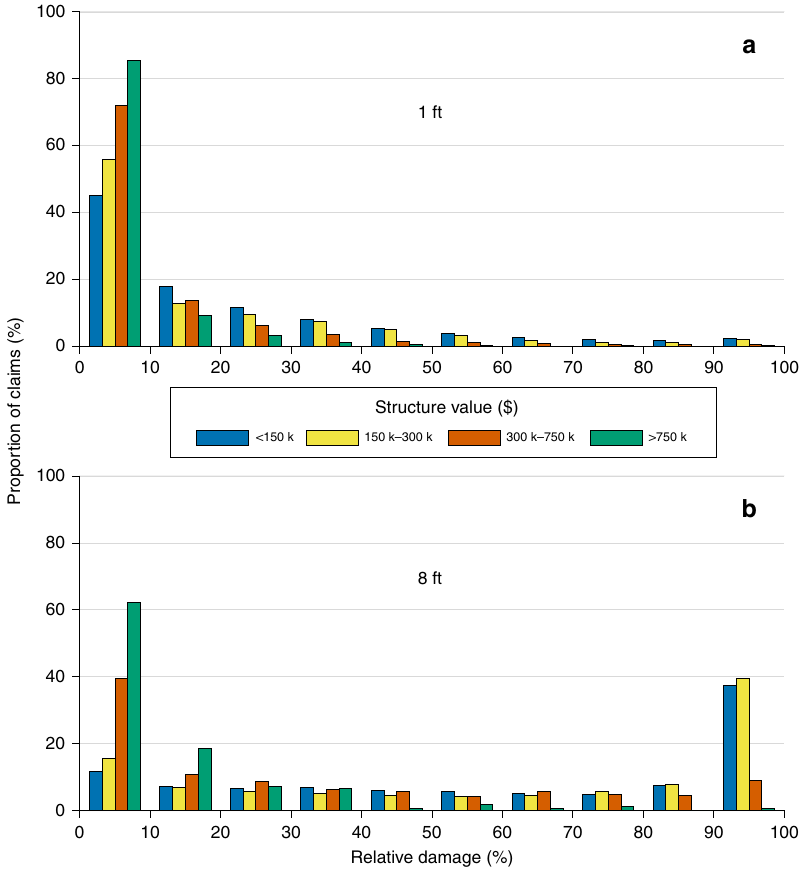
Fig. 4 Relative damage to one-story, no-basement residential homes of different values. Sample water depths are illustrated: 1 foot ( a ) and 8 feet ( b ). Damages are binned in increments of 10%: e.g., 62% of claims relating to structures of value >$750,000 where 8-feet of inundation occurred incurred between 0 and 10% relative